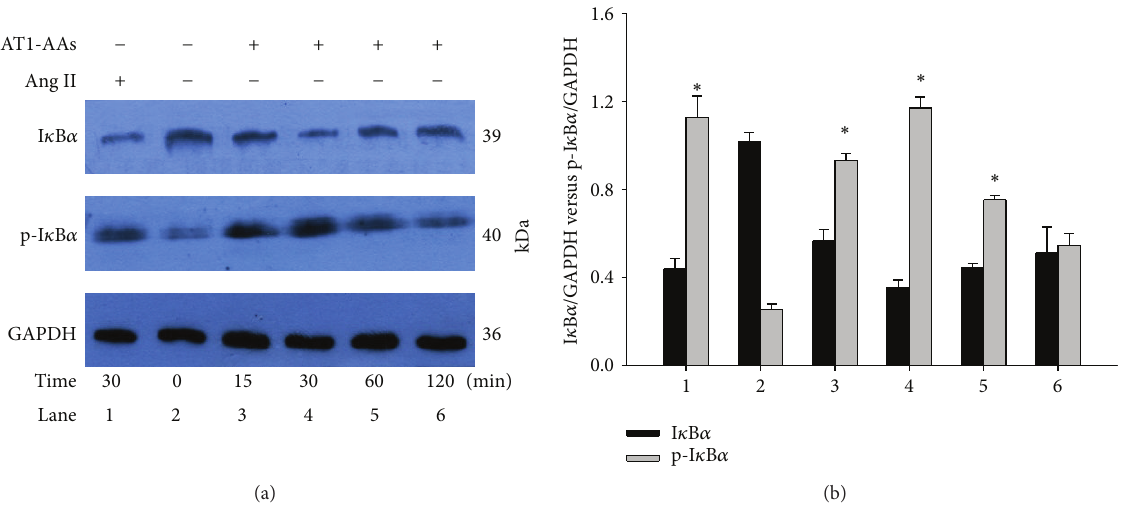
Figure 8: Cytoplasm I 𝜅 B 𝛼 and p-I 𝜅 B 𝛼 expression in human endothelial cells after stimulation with AT1-AAs. The cells were incubated with AT1-AAs after 0, 15, 30, 60, and 120min and angiotensin II (0.1 𝜇 M) for 30 min; I 𝜅 B 𝛼 and p-I 𝜅 B 𝛼 levels were determined by Western blot analysis (panel (a)). Angiotensin II was used as positive control (lane 1). Data were summarized in panel (b) from 5 independent experiments; ∗ 𝑃 < 0.05 versus 0 min (control) group (lane 2) in p-I 𝜅 B 𝛼 group.